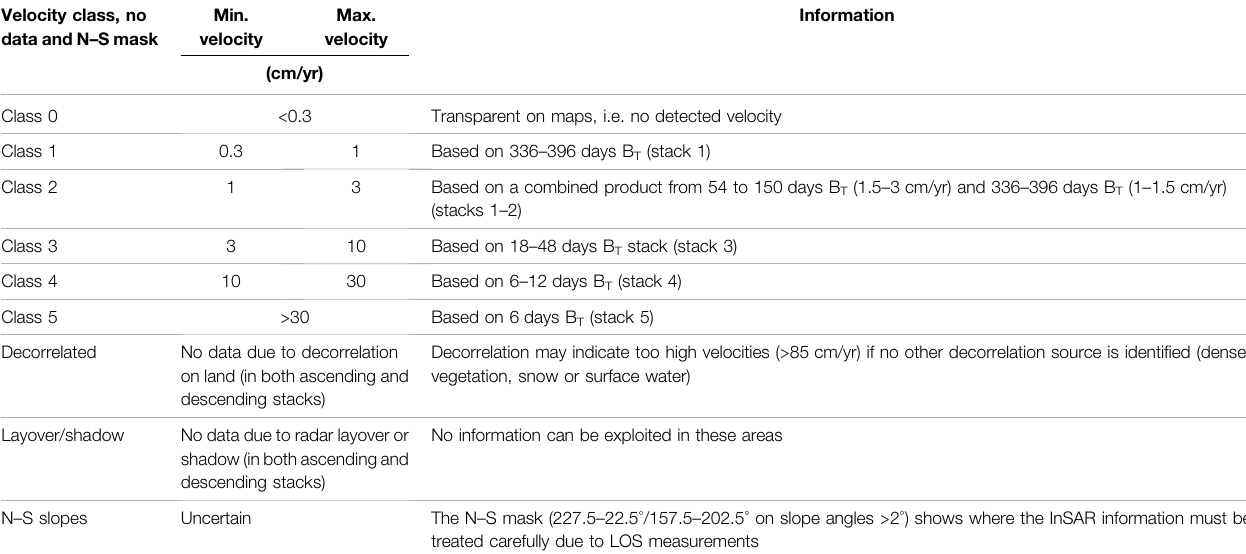
TABLE 2 | Velocity classi fi cation basedon InSAR resultsfrom fi ve stacksin both ascending and descending geometries( Table 1 ).Acronymsrefer toBT(temporalbaseline, i.e. time interval between SAR acquisitions) and LOS (line-of-sight). Velocity class, no Min. data and N – S mask